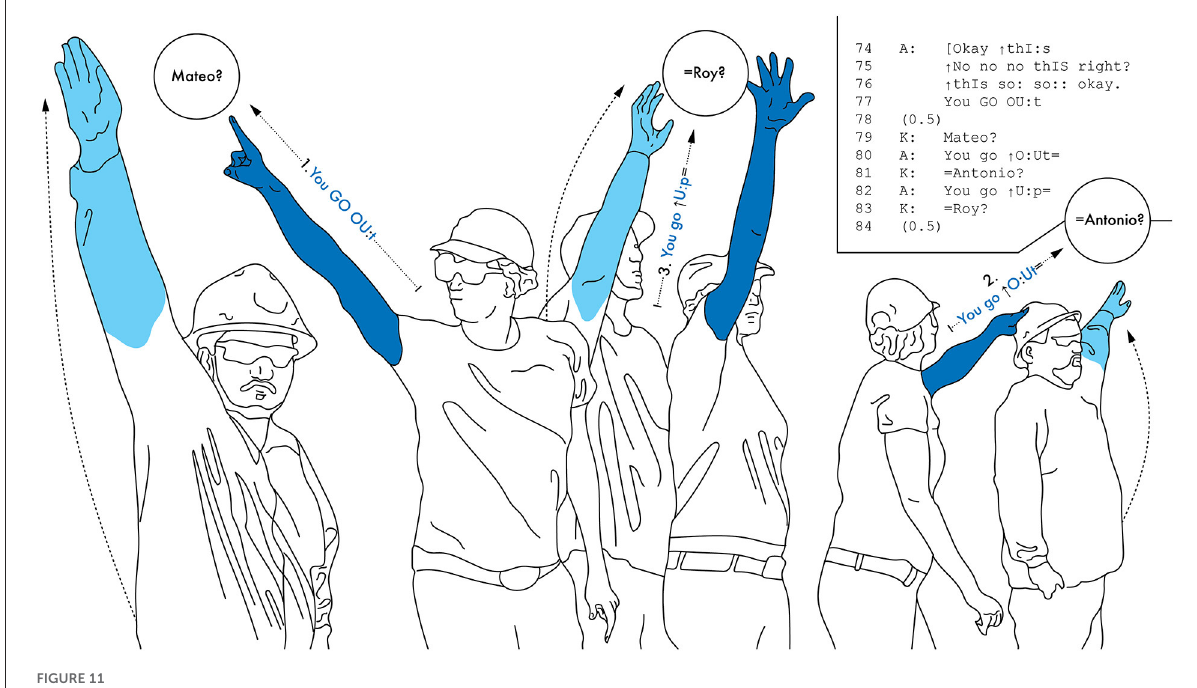
FIGURE11 Transcript 2.4a.